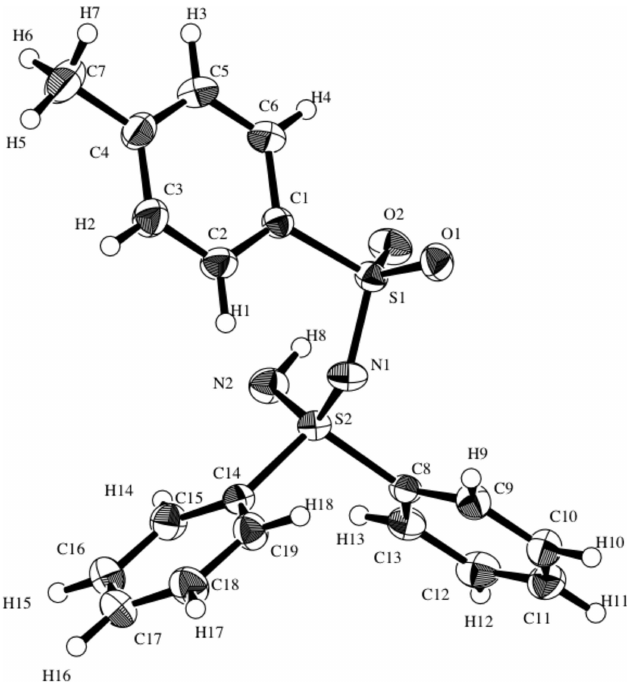
Figure 1 The molecular structure of the title compound, showing the atom labelling. Displacement ellipsoids are drawn at the 50% probability